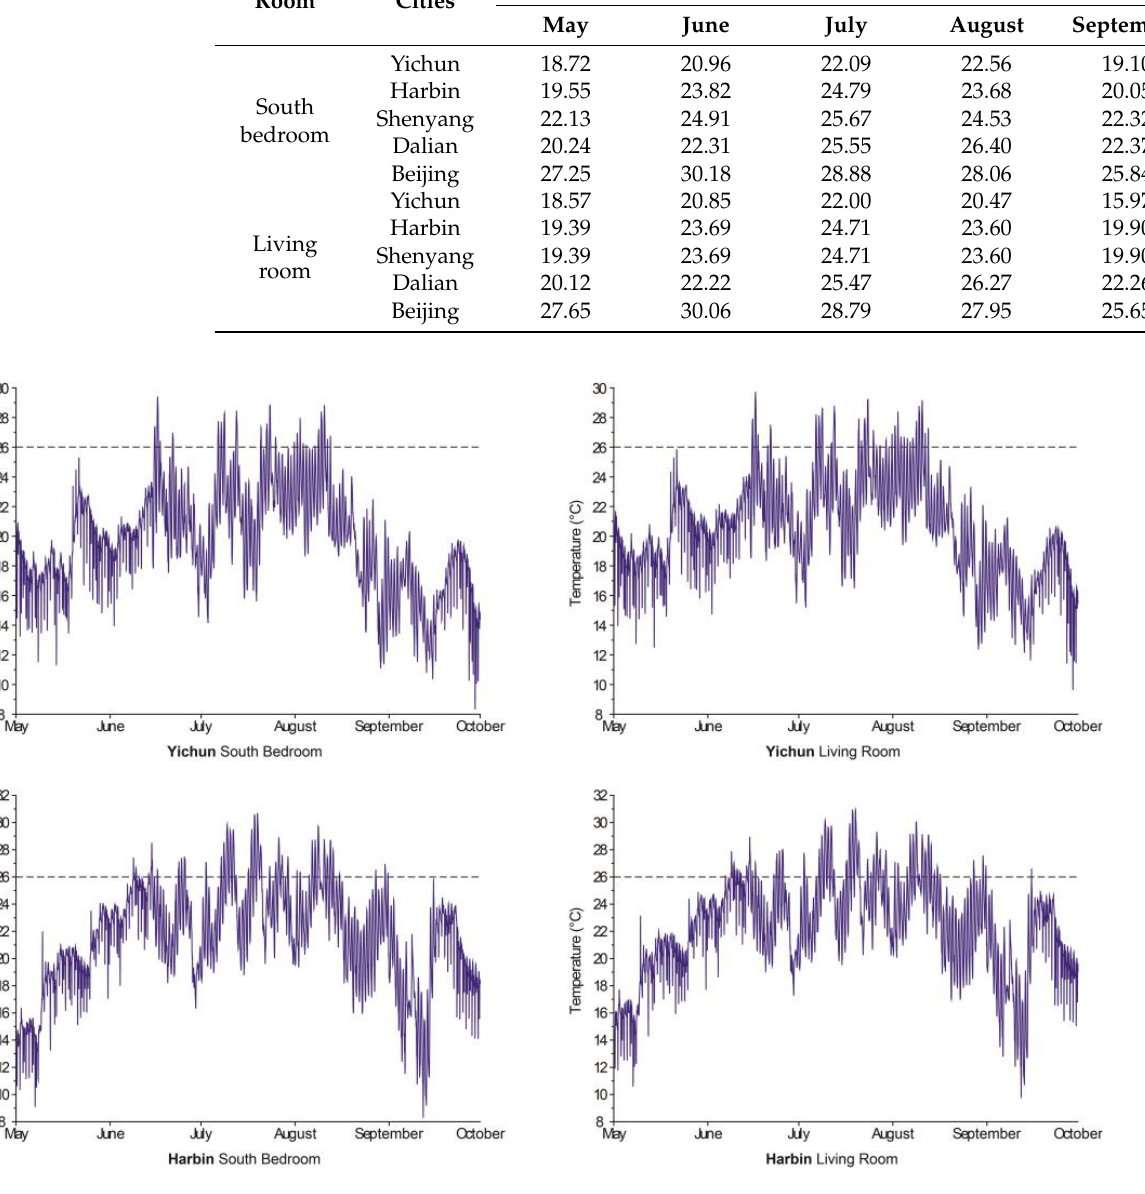
Figure 11. Indoor operative temperature in five representative cities from May to September.